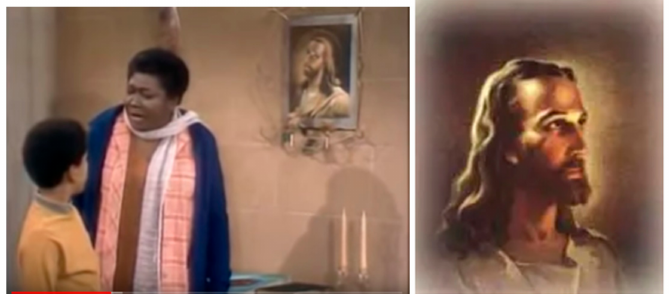
Figure 2. The painting of White Jesus displayed in the Evans home ( left ), and Warner Sallman’s mass-produced painting of White Jesus ( right ). Screenshot captured from “Thank You Black Jesus.” Good Times: The Complete First Season , Columbia Tristar Home Entertainment,